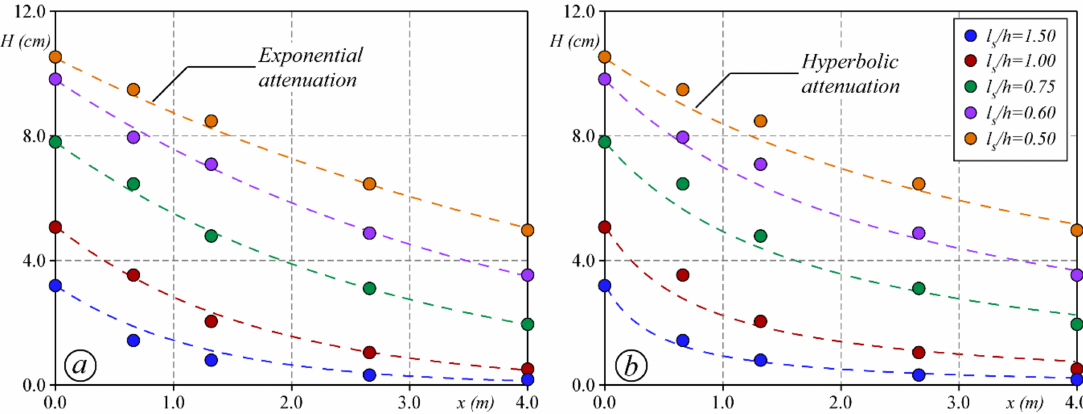
Figure 5. Wave height H along the vegetated reach when density is n p = 312.5 plant/m 2 and the relative vegetation height is in the range 0.5 ≤ l s / h ≤ 1.5. Wave period and slope are T = 1 s and H 0 / L = 0.08. Circles denote the experimental data, dashed line are the modeled wave attenuation either with ( a ) the exponential model given by Equation (6); or ( b ) the hyperbolic model given by Equation